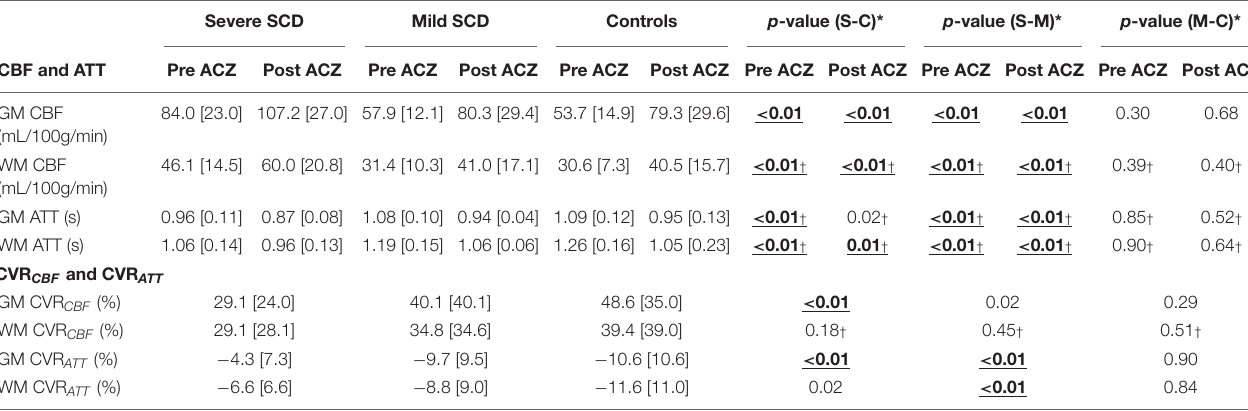
TABLE 2 | CBF and ATT before and after ACZ administration and CVR CBF and CVR ATT [median (interquartile range)] per participant group with p -values between groups. Severe SCD Mild SCD Controls p -value (S-C)*